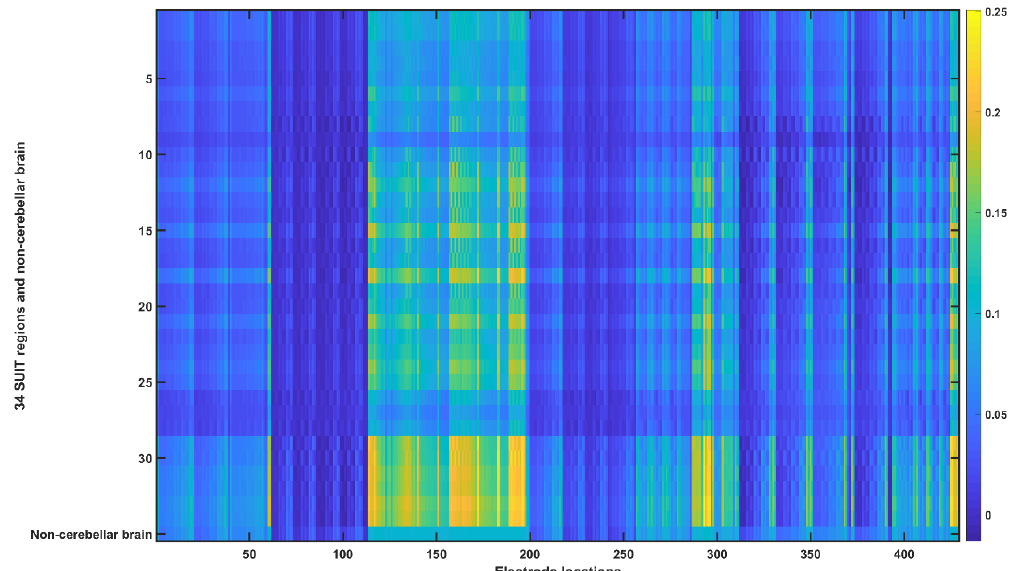
Figure A8. Ez transfer matrix for the head model from the 55–59 years old MRI template. The X-axis shows the electrode locations (refer Appendix B) and Y-axis shows the 34 SUIT regions (refer Appendix A) and non-cerebellar brain.